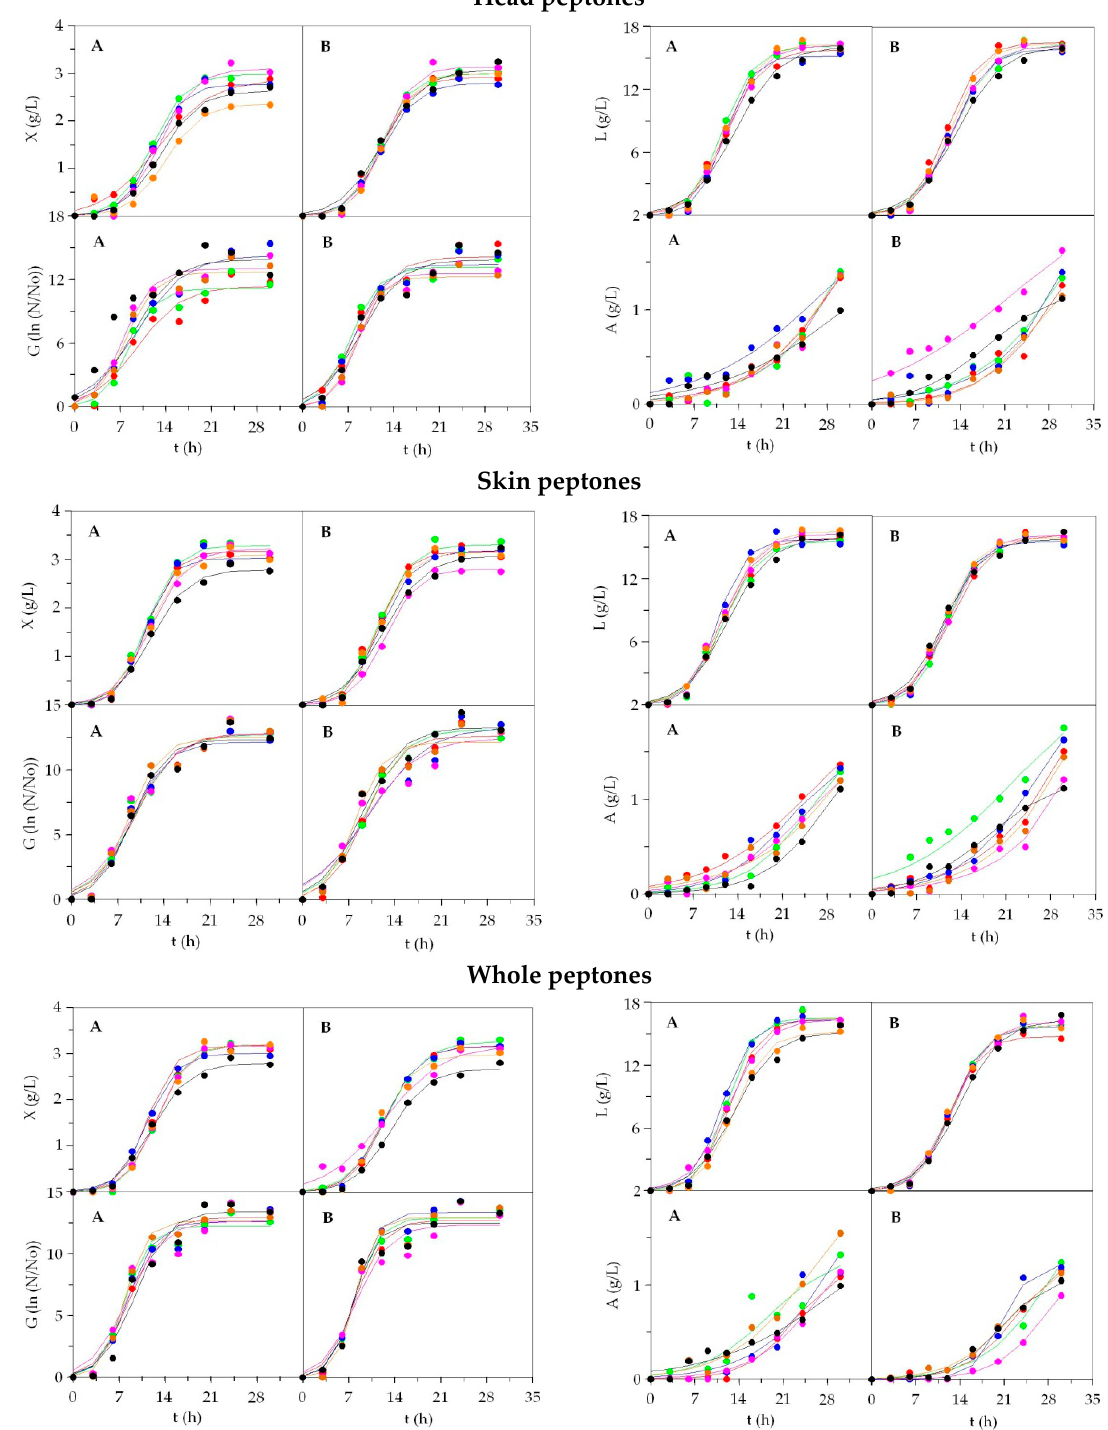
Figure 2. Culture kinetics of Lb 2 in alternative media based on marine peptones from discarded fish and by-products. Peptones A: • : BW; • : RS; • : Ma; • : Po; • : Gu; • : MRS. Peptones B: • : Gr; • : Me; • : Ha; • : Bo; • : AHM; • : MRS. Experimental data of biomass (X), viable cells (G), lactic acid (L), and acetic acid (A) were fitted to the logistic equation. The confidence intervals of experimental data (for two replicates) were in all cases less than 15% of the experimental mean values and omitted for clarity .